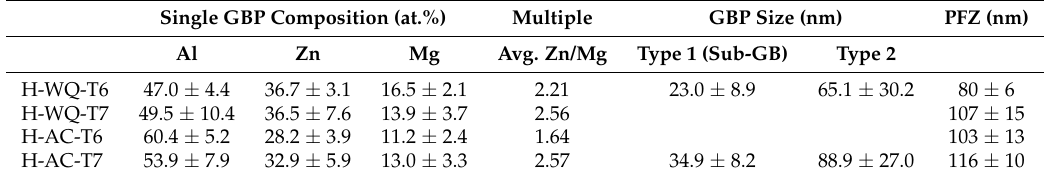
Figure 6. BF-STEM images of a cell structure consisting of sub-grain boundaries (type 1) with high density of grain boundary particles in ( a – c ). ( d , e ) shows two type 2 grain boundaries with particles of different size, shape and distance between. ( f ) is a HAADF-STEM image of a type 3 grain boundary, where no particles are present and the PFZs are clearly visible. ( c ) is acquired in sample H-AC-T6, while the rest is from H-WQ-T6, all obtained parallel to the extrusion direction. The particles are the MgZn 2 phase. Table 2. Compositional analysis using TEM-EDS of grain boundary particles (GBPs) in each condition acquired in microscope (ii). Average Zn/Mg ratio of ∼ 150 GBPs acquired using microscope (i) represented in the column named ‘Multiple’. Average GBP size with corresponding standard deviation measured at grain boundaries with dense and non-dense particle distribution in the two conditions with the largest difference in measured SCC properties. Average width of PFZs acquired from 10 grain boundaries in each